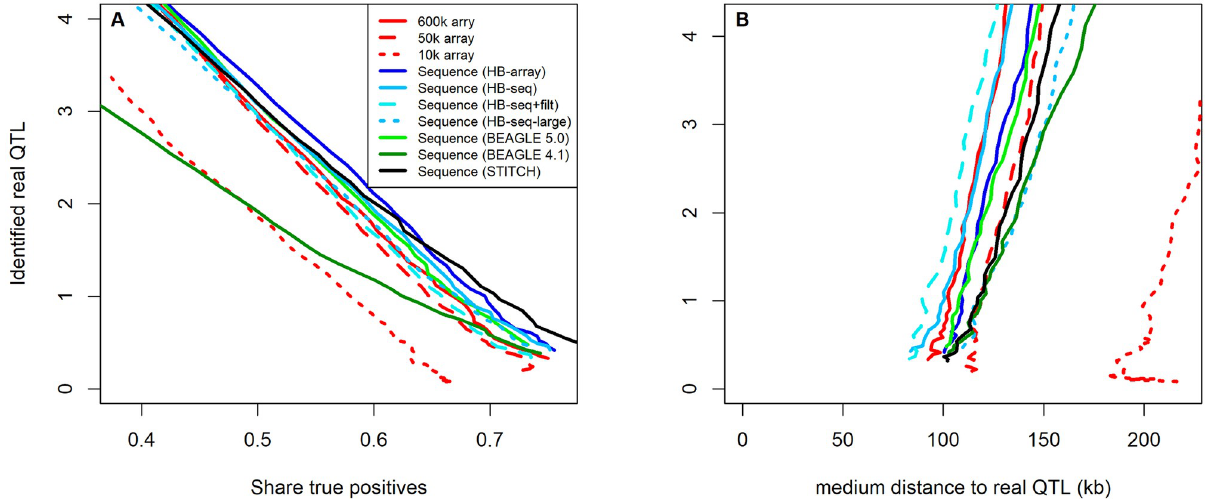
Fig 5. Number of positive GWAS hits for simulated traits with 10 underlying QTL depending on the share of true positive hits (A). Median distance of the local GWAS peak (highest p-value) and the underlying true QTL for correct GWAS hits (B).